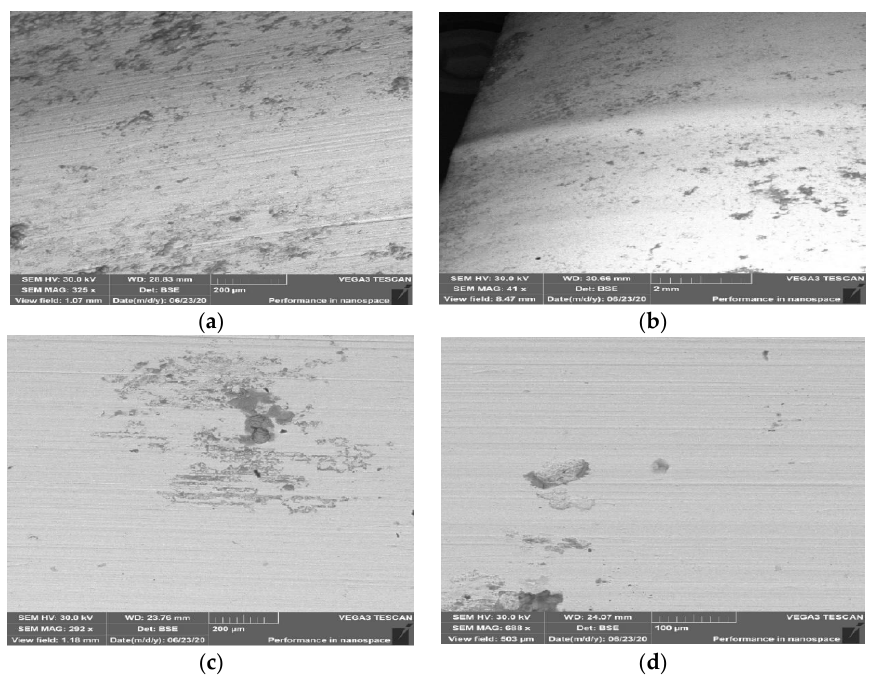
Figure 16. Surface topography of samples made of Hardox 600 steel: ( a ) external surface for sample from area 1; ( b ) core for sample from area 1, for lower tool; ( c ) external surface for sample from area 2; ( d ) core for sample from area 2, for lower tool. SEM.